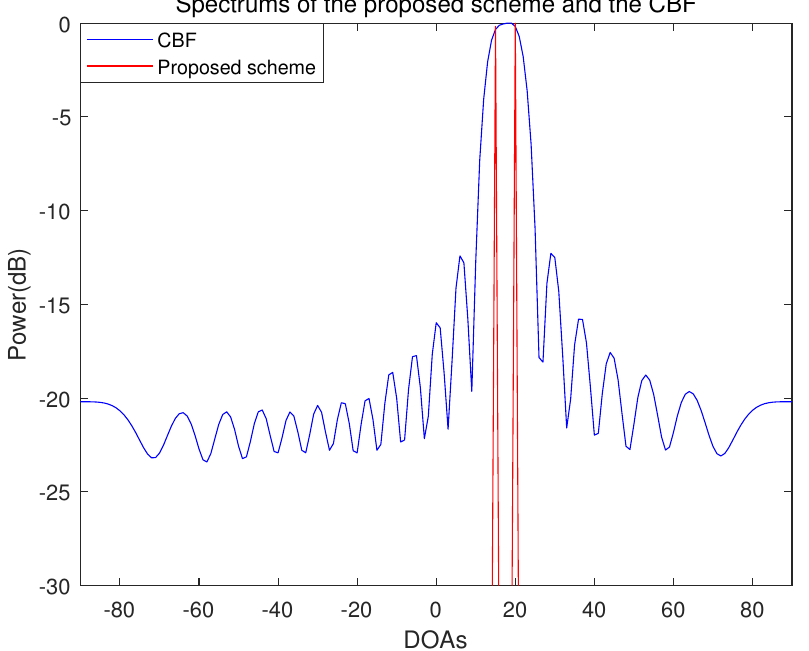
Figure 4. Spectrum of the proposed scheme and the conventional beamforming algorithm when the number of sensors is 20, the number of samples is 500 and the incident angles are 15 ◦ and 20 ◦ (SNR = 10